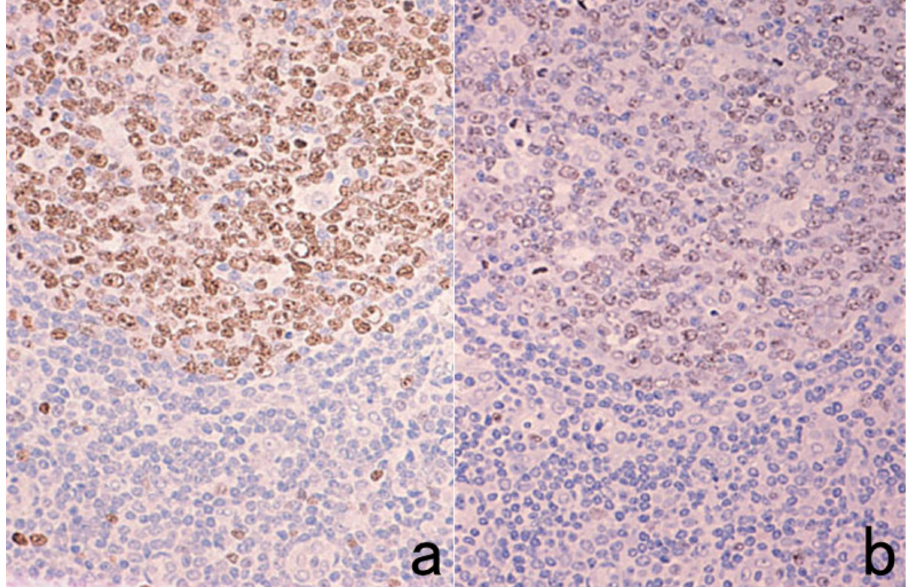
Figure 38. Weakening of Ki-67 immunoreactivity by overnight antibody incubation after HIER with pressure pan heating at 121 ◦ C for 10 min in 10 mM citrate buffer, pH 6.0. ( a ): One-hour antibody incubation and ( b ): overnight incubation. Ki-67 labeling in the germinal center lymphocytes